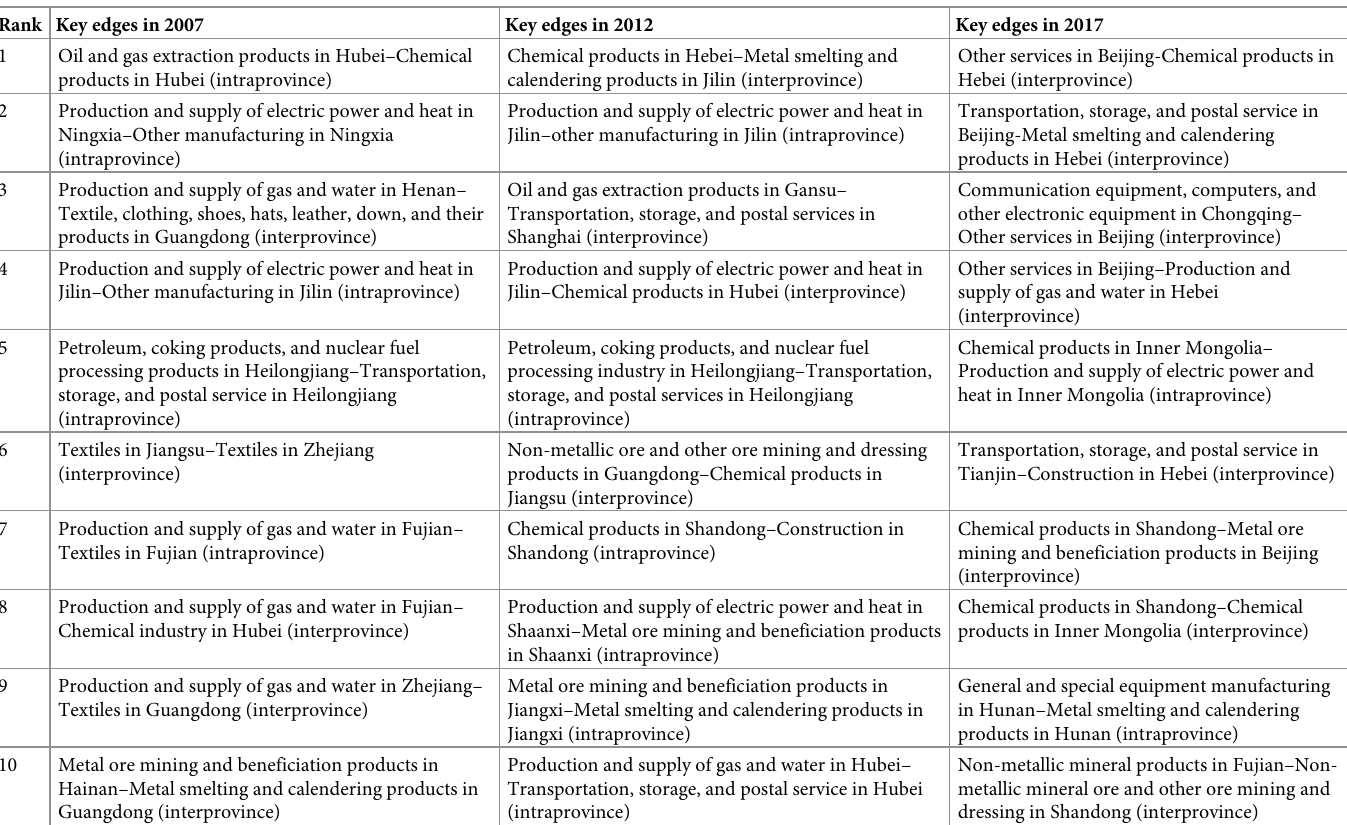
Table 3. Top ten key edges of the embodied carbon flow networks of China’s exports. Rank Key edges in 2007 Key edges in 2012 Key edges in